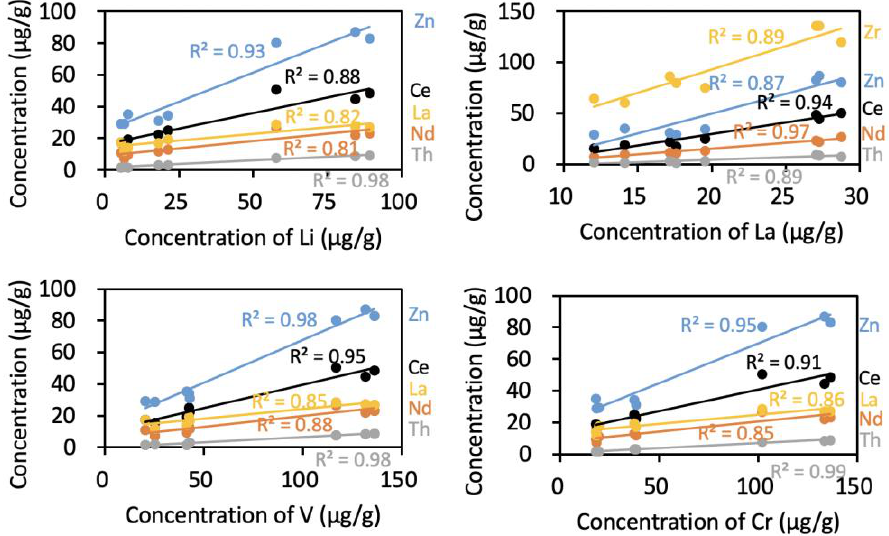
Figure 4. Correlation of selected elements of high anomaly for the samples collected from Agost and Caravaca, Spain.